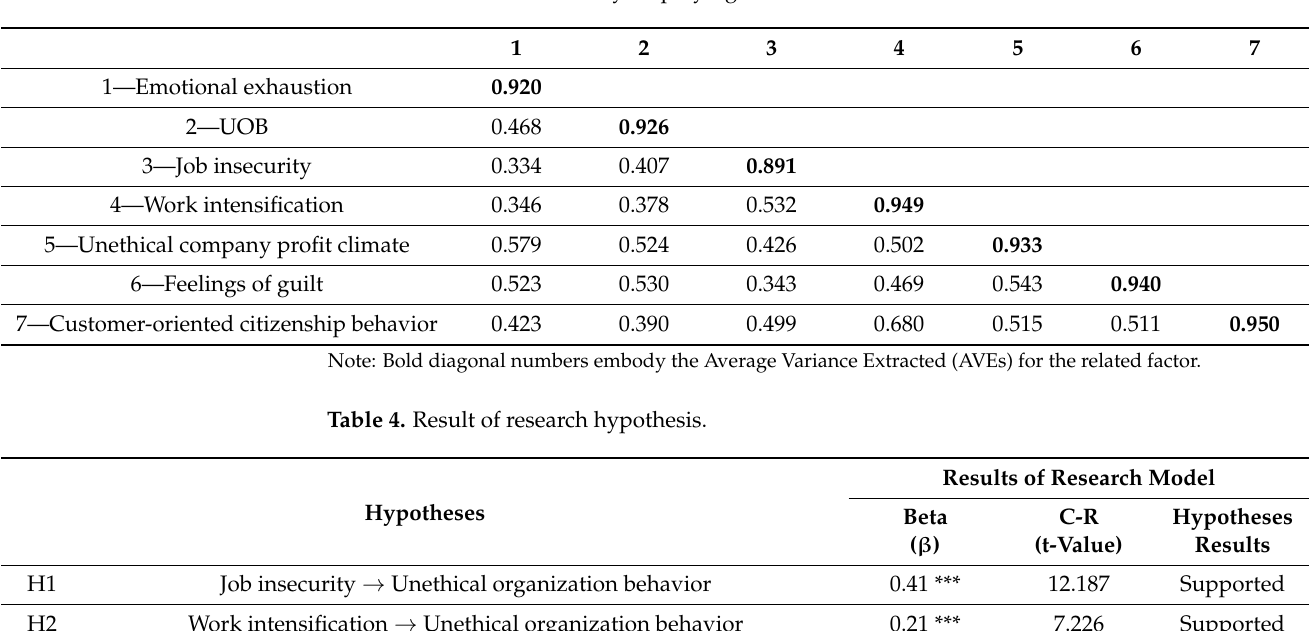
Table 3. Discriminant validity employing the Fornell–Larcker criterion